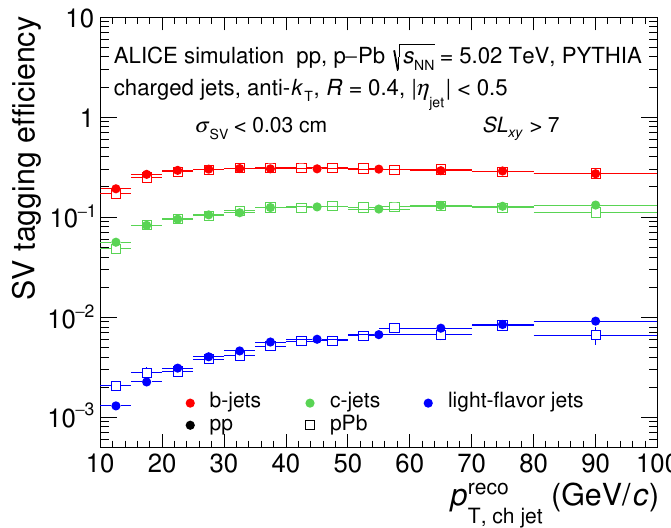
Figure 7. Beauty-jet tagging efficiencies, as well as charm-jet, and light-flavor jet mistagging efficiencies for the SV method in pp (solid markers) and p-Pb (open markers) collisions at 5 . 02 TeV, shown as a function of jet transverse